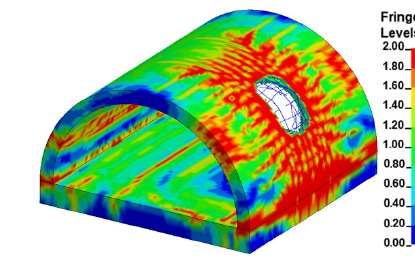
Table 11. Mass of the potential explosion threats.